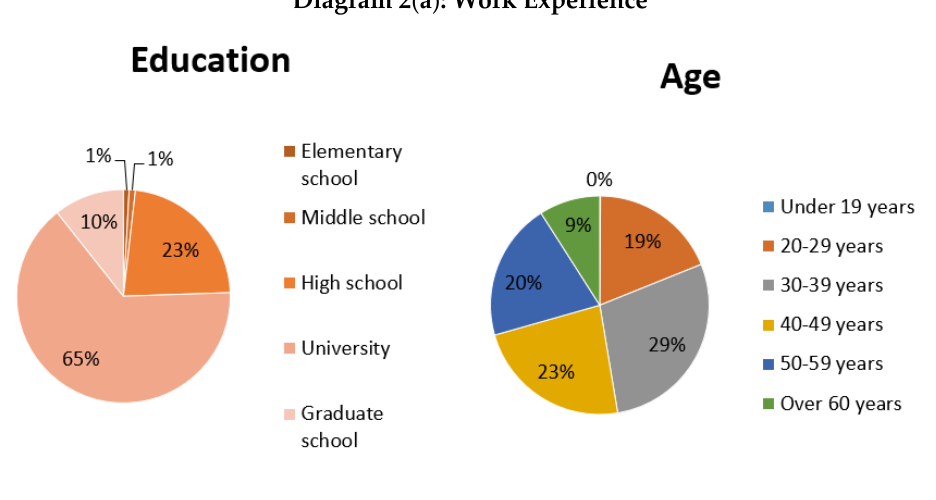
Figure 2. Respondents’ Demographic Data.